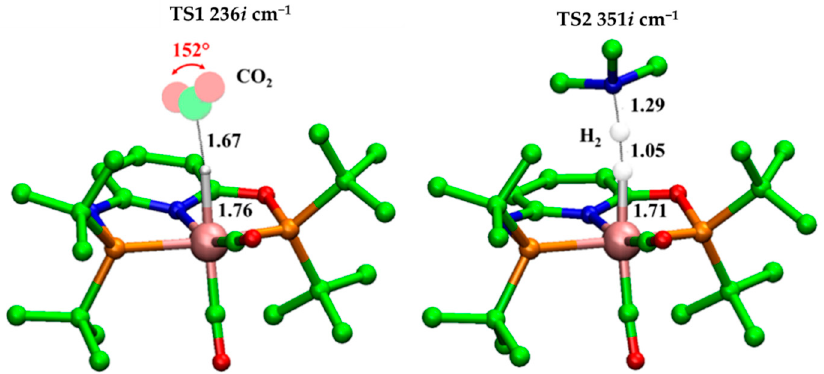
Figure 3. B3LYP-D3/6-31+G(d,p) optimized geometries of TS1 and TS2 . Relevant distances (in black) are in Å. Imaginary frequencies are also indicated. For clarity, hydrogens were not repre- sented.